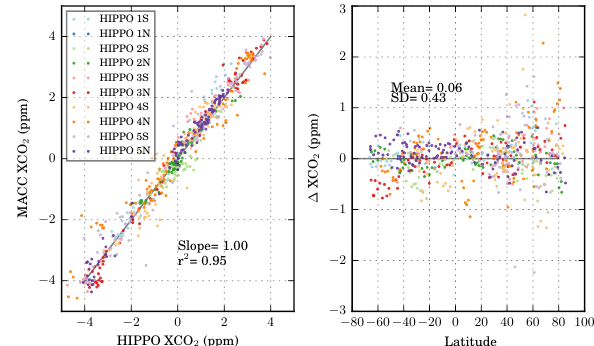
Figure 6. Left: scatter plot of normalized (with campaign average) XCO 2 computed from individual HIPPO profiles ( x axis) against corresponding MACC data. Right: difference plot of XCO 2 against latitude. Campaigns as well as north and southbound tracks are color